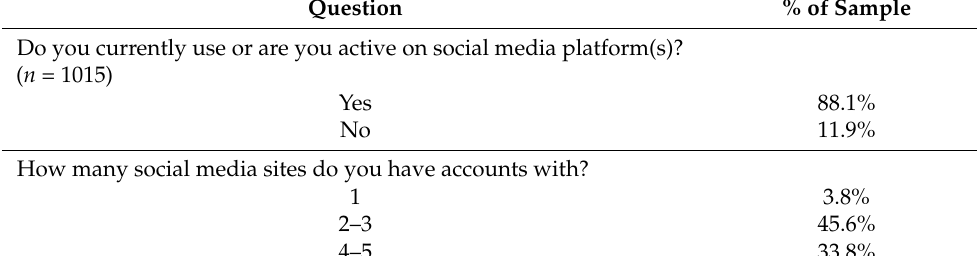
Table 4. Social Media Use among Dietetics Students, Dietetic Interns, and Currently Practicing and Retired Nutrition and Dietetic Technicians Registered and Registered Dietitian Nutritionists a . Question % of Sample Do you currently use or are you active on social media platform(s)? ( n = 1015) Yes